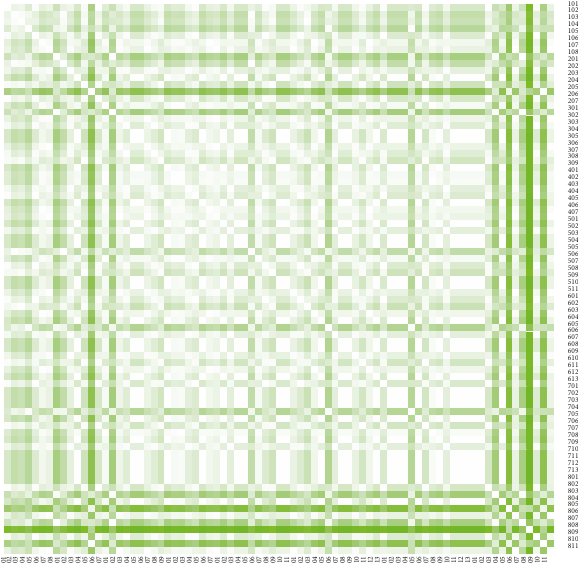
Figure 15: The distance matrix of the similarity of the districts for the female sex in 2010.